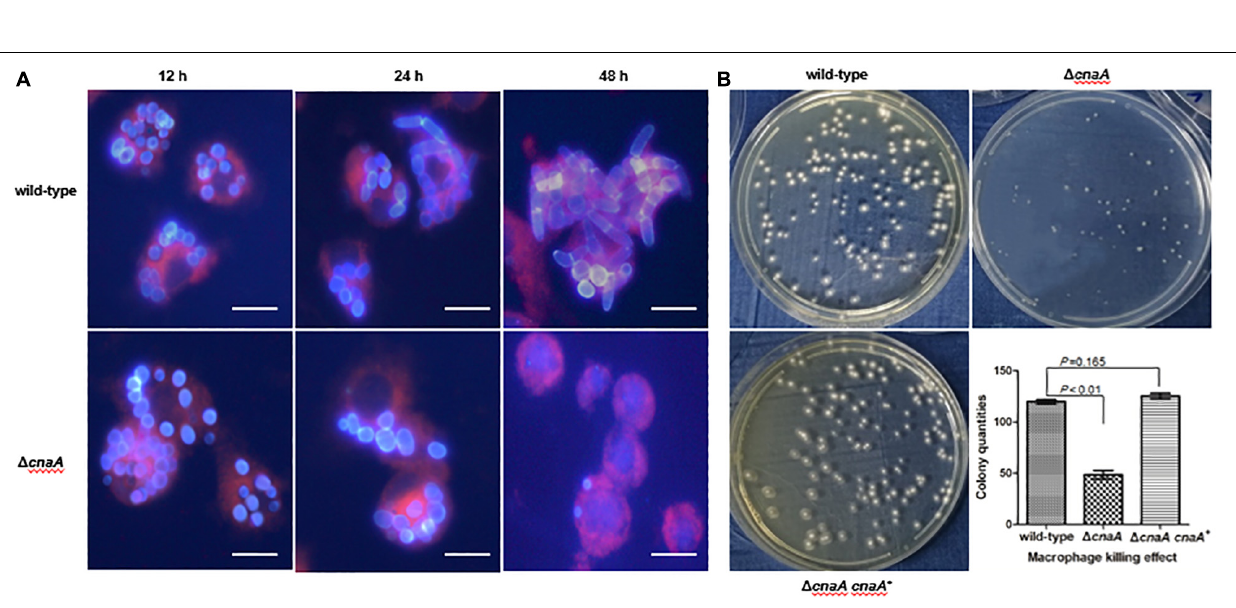
FIGURE 6 | The cnaA gene is essential for immune escape in macrophages. (A) Wild-type and (cid:49) cnaA strains were co-cultured with RAW264.7 macrophages and observed by confocal microscopy. After 12, 24, and 48 h following phagocytosis, the (cid:49) cnaA mutant conidia showed increased sensitivity to the cytotoxic activity of the macrophages and were killed and eliminated, compared with the wild-type, which germinated into yeast cells and replicated profusely intracellularly. Scale bars, 20 µ m. (B) Conidial survival was measured by counting CFU on SD medium after lysis of T. marneffei -infected macrophages. The number of surviving (cid:49) cnaA mutant cells was drastically lower than the number of surviving wild-type cells ( P <